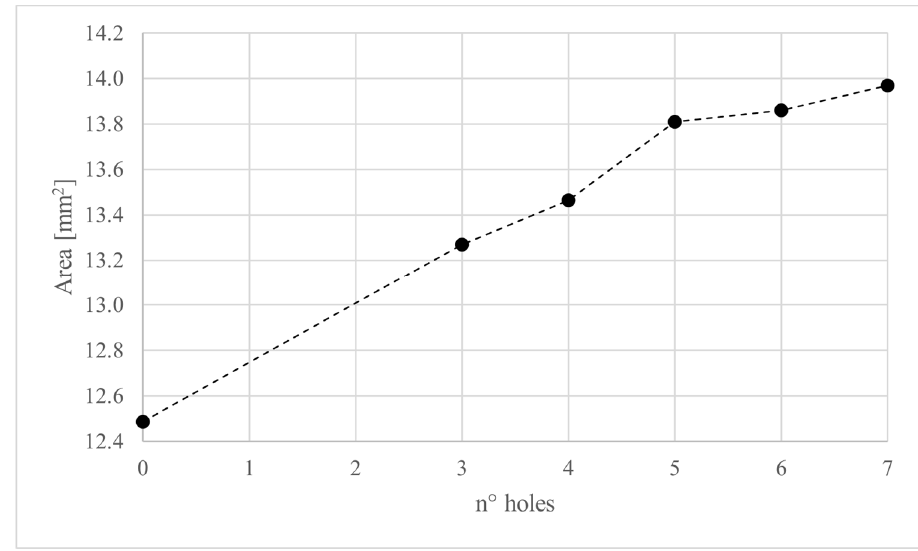
Figure 4. Variation of internal lumen area with respect to the number of holes, considering the cases H3, H4, H5, H6, and H7.